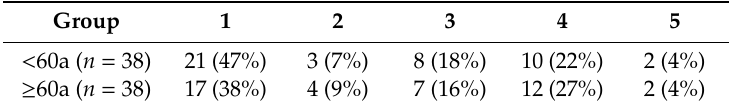
Figure 4. Clinical outcome of non-union treatment based on the “diamond concept”. Here pain associated with weight-bearing in respect to patients’ age ( a ) and consolidation status ( b ) is shown using box plots. Whiskers indicated minimum and maximum, band inside box indicates median. Table 3. Pain